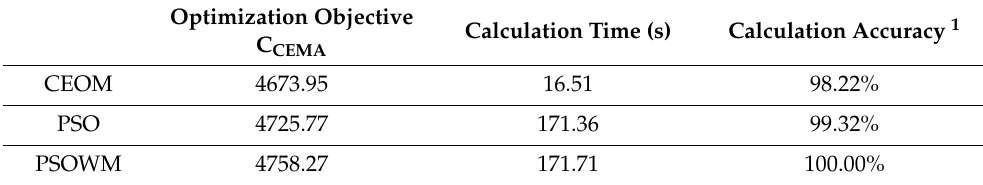
Table 5. Performance with applying CEOM, PSO, and PSOWM in